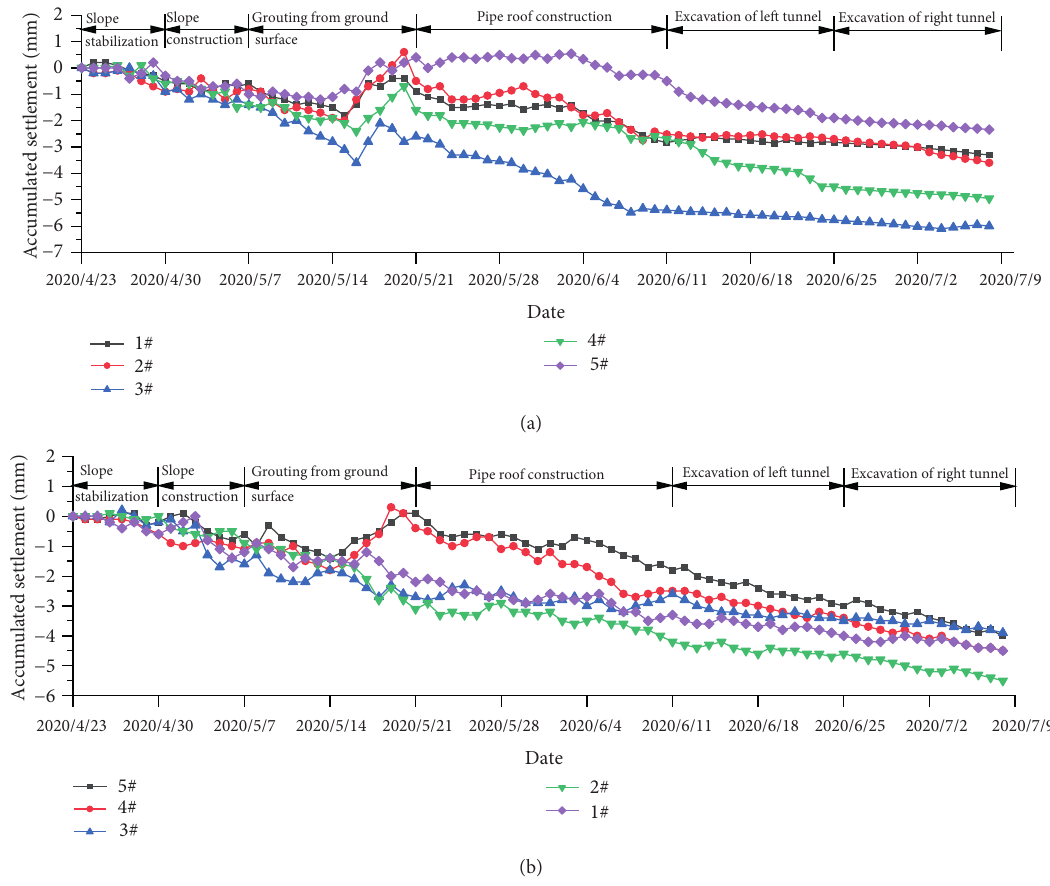
Figure 13: Monitoring data of representative measuring points. (a) Cumulative settlement map. (b) Cumulative horizontal displacement map (+: outward expansion; − :